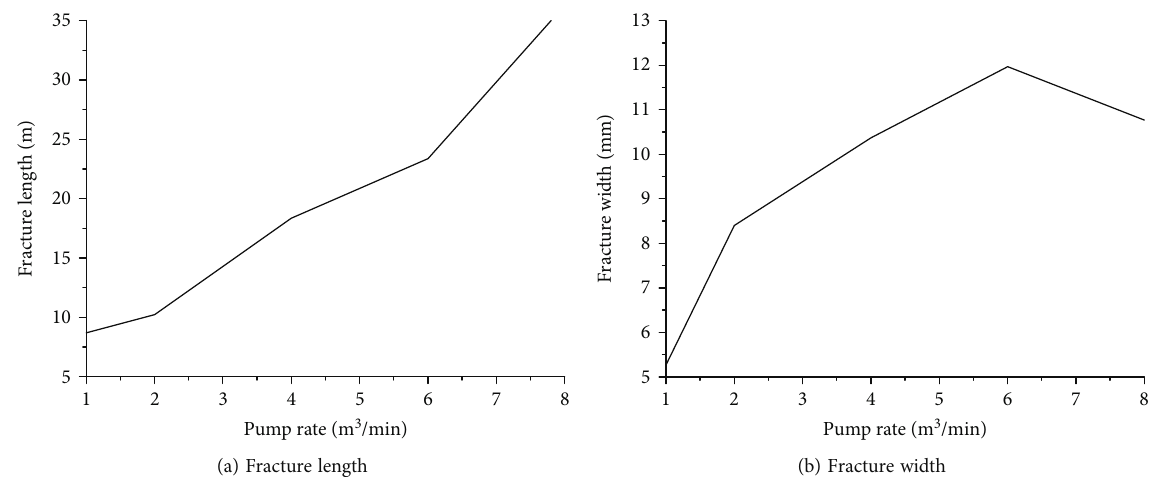
Figure 28: Fracture length and width at the NF approaching angle of 45 ° and at the rate of 1-8m 3 /min.